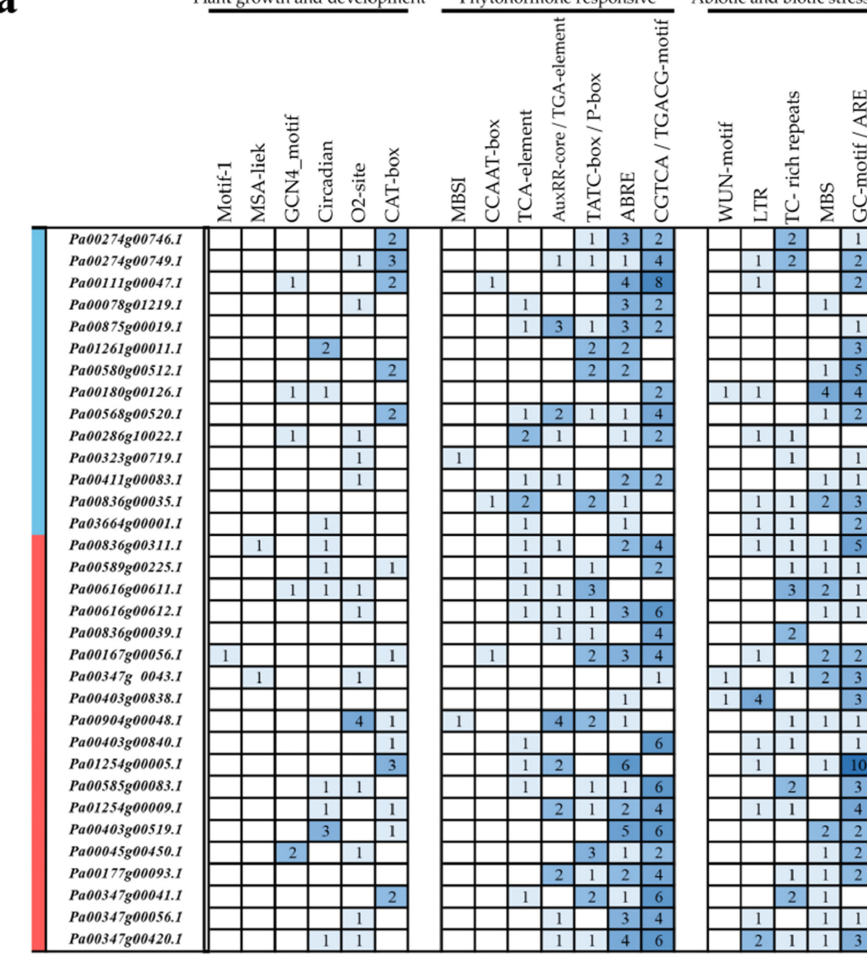
Figure 8. Cis-acting elements analysis in the promoter of PaCTL gene family members. ( a ) Number of each cis-acting element in the promoter region (2 kb upstream of the translation start site) of PaCTLs . The genes marked in blue region were the members of the GH19 subgroup, and the genes